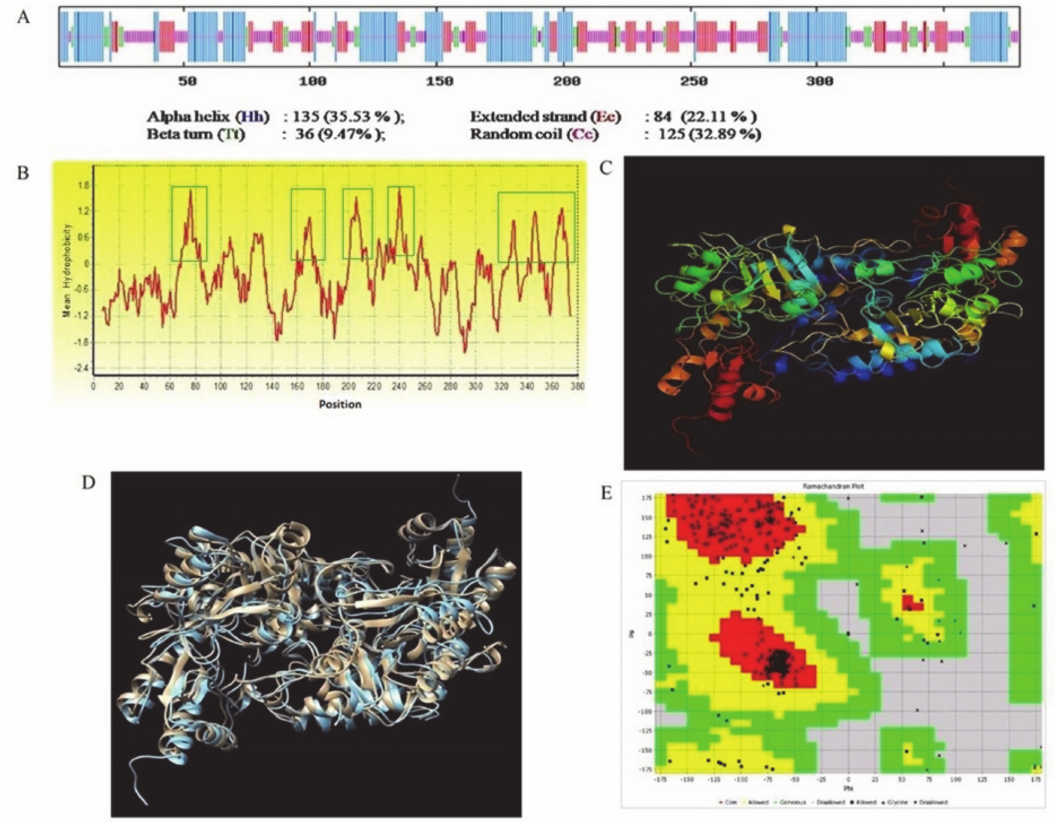
Figure 1. Represents the results of the predicted structural analysis of K. pneumoniae histidine decarboxylase protein. ( A ) Secondary structure conformation parameters of K. pneumoniae histidine decarboxylase based on self-optimized prediction method with alignment (SOPMA) analysis. Helices, extended strand / sheets, beta turns, and random coils are indicated with the blue colored longest lines, the redcolored second longest lines, the green colored second shortest lines, and thepink colored shortest vertical lines, respectively. Most of the secondary structure of K. pneumoniae histidine decarboxylase is composed of alpha helix, which is followed by random coil, extended stand, and beta-turn, respectively. ( B ) Hydropathy plot of K. pneumoniae histidine decarboxylase shows that it is hydrophobic in nature. Green line box depicts the presence of more than 7 non-polar amino acid residues such as Glycine, Alanine, Proline, Valine, Leucine, Isoleucine, Methionine, Tryptophan, and Phenylalanine in structural topology, which increases the stability of the protein and prevents hydrolysis. More positive values indicate more hydrophobic amino acids located in that region of histidine decarboxylase (HDC) protein. ( C ) Homology-modeled three-dimensional structure of K. pneumoniae histidine decarboxylase, using Methanocaldococcus jannaschii L-tyrosine decarboxylase (pbd id 3f9tA) as the template structure. ( D ) Superimposition of the predicted structure of K. pneumoniae histidine decarboxylase with the template M. jannaschii L-tyrosine decarboxylase (pbd id 3f9tA). Superimposition of modeled histidine decarboxylase of K. pneumoniae to the template M. jannaschii L-tyrosine decarboxylase structure revealed the perfect homology among the structures. Pale orange color represents the 3D structure of the template protein, while the blue color represents the 3D structure of K. pneumoniae HDC superimposed on the template structure. ( E ) Ramachandran plot of the predicted K. pneumoniae histidine decarboxylase 3D model. Presence of the majority of amino acids in the allowed region (yellow) of the Ramachandran plot revealed the quality of the modelled 3D structure of K. pneumoniae histidine